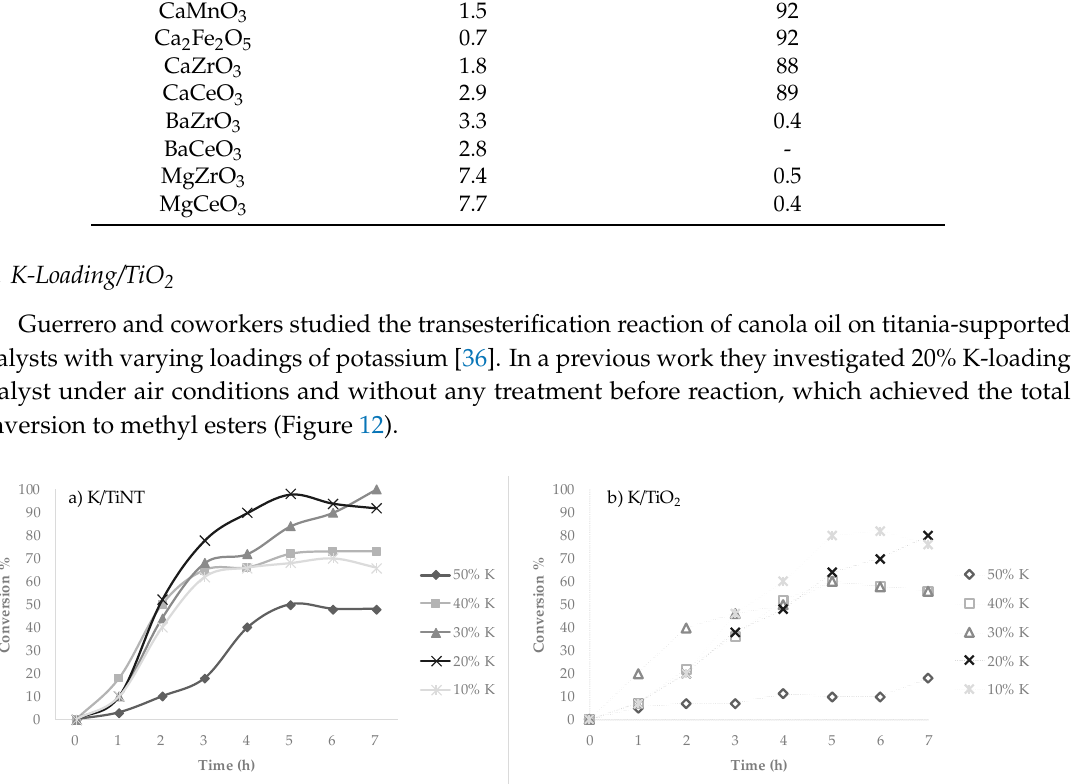
Table 12. Catalytic activity of the NaK(X)TNT (X refers to the percentage of the potassium loaded) samples.